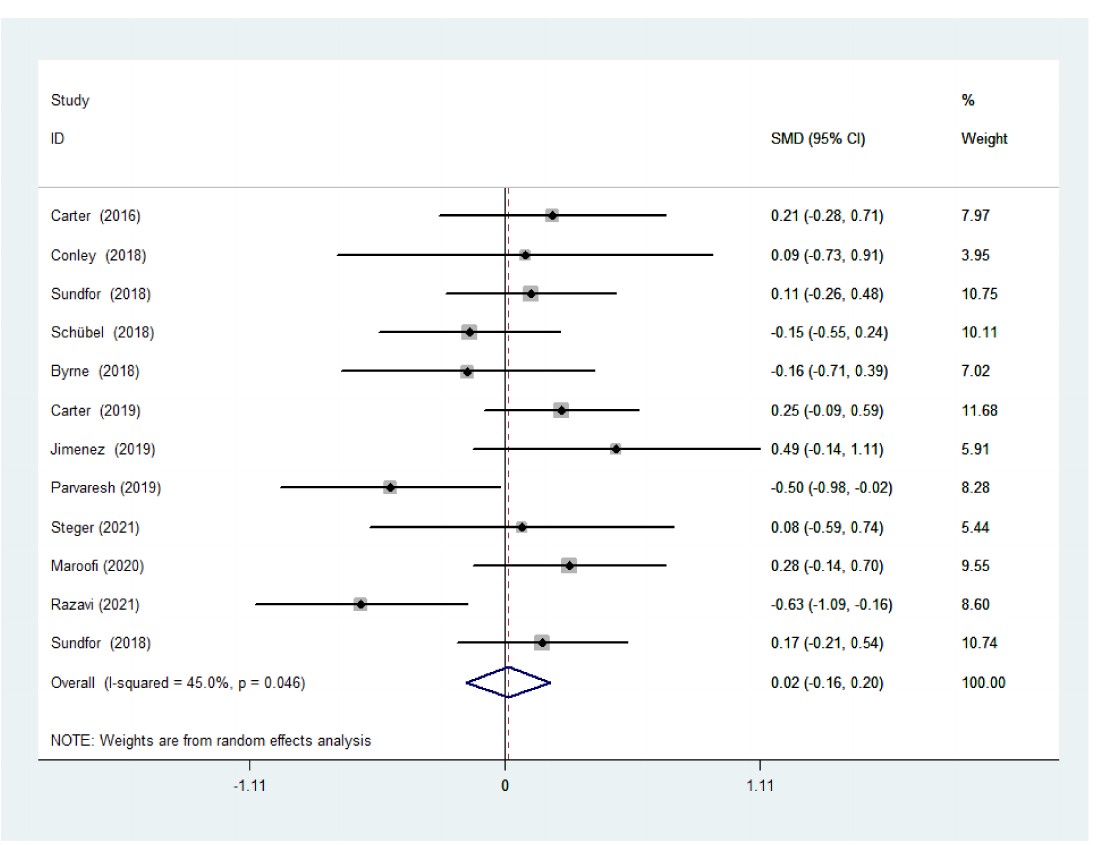
Figure 2. The weighted mean difference in BMI (kg/m 2 ) between the IF and CCR (SD: standard deviation; CI: confidence interval).